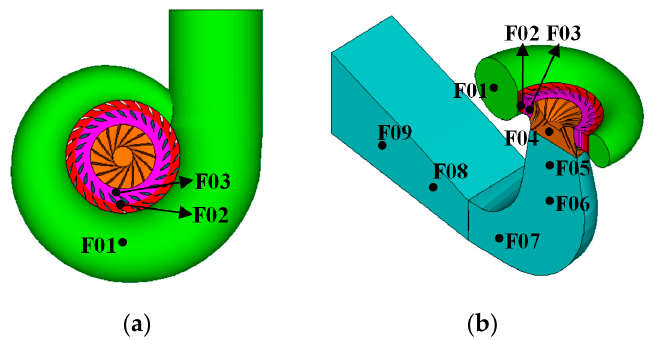
Figure 4. Measuring points distribution in the fluid flow region during numerical calculation process. ( a ) Top view section diagram, ( b ) river-along section diagram.